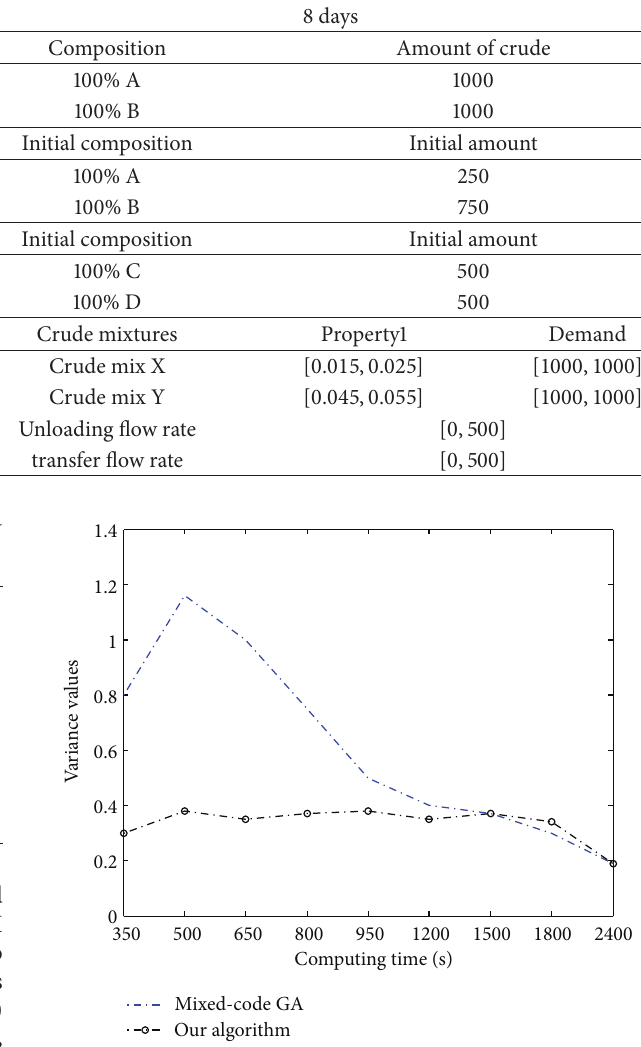
Figure 7: Variance values of two